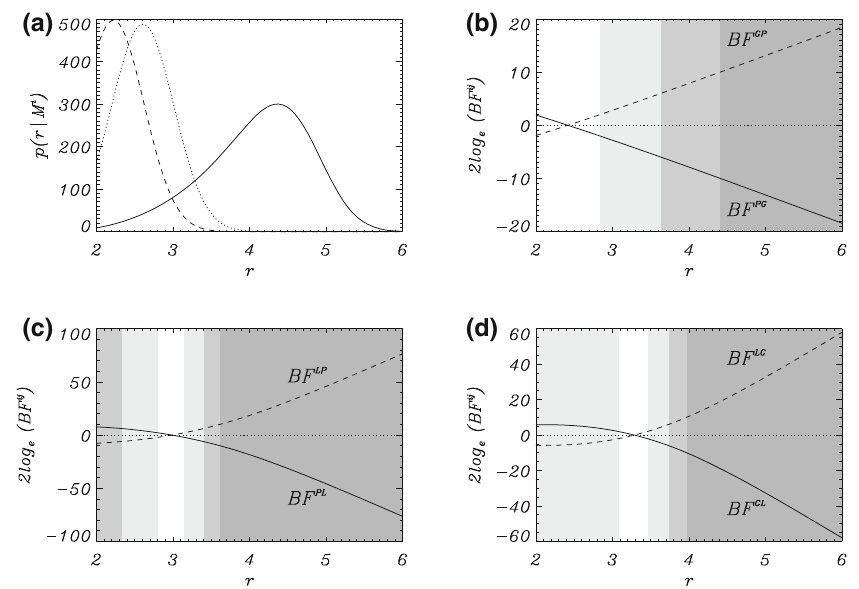
Fig. 94 a Marginal likelihoods for three density models considered by Arregui and Soler (2015) as a function of the observable period ratio ( r ): p ( r | M P ) as a dashed line, p ( r | M G ) as a dotted line and p ( r | M L ) as a solid line. b – d Bayes factors for the model comparisons between b the parabolic, M P , and the Gaussian, M G , density models; c the parabolic, M P , and the Lorentzian, M L , density models; and d the Gaussian, M G , and the Lorentzian, M L , density models, as a function of the period ratio. Different shades of grey limit ranges in period ratio with different levels of evidence for one model being preferred against the alternative, depending on the magnitude of the Bayes factors and following the empirical table by Kass and Raftery (1995), described in the text. White regions indicate values of period ratio for which there is minimal evidence for any of the models that are being compared. Then, different shades of grey indicate regions with positive, strong and very strong evidence, with the level of evidence being larger for darker regions. Image reproduced with permission from Arregui and Soler (2015), copyright by